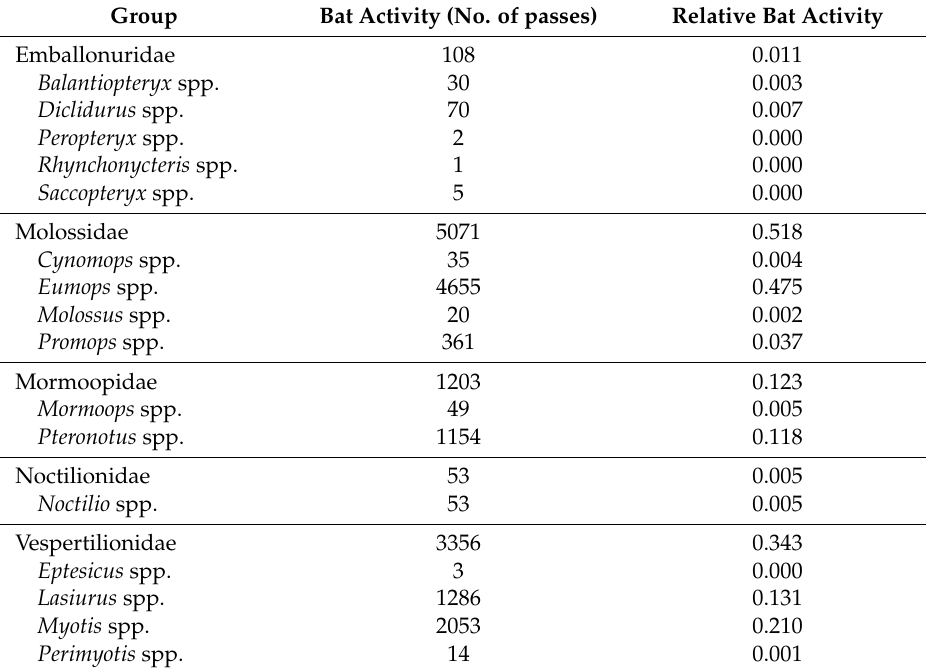
Table 2. Bat activity in the Chiquibul Forest Reserve (CFR), Belize, Central America, in summer 2014. Group Bat Activity (No. of passes) Relative Bat Activity Emballonuridae